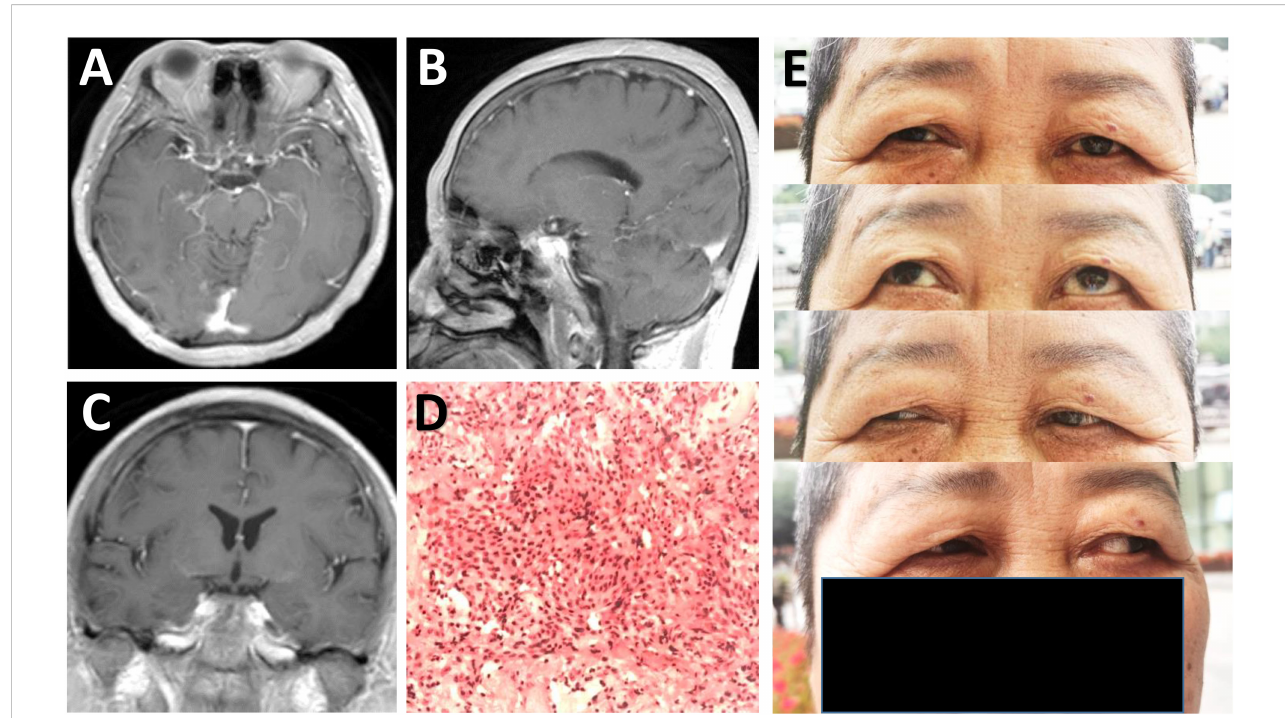
FIGURE 3 Radiological and pathological evaluation of the lesion postoperatively. (A-C) Postoperative post-contrast axial (A) , sagittal (B) , and coronal (C) MRI scans performed one month after surgery showing total removal of the lesion. (D) Photomicrograph of hematoxylin-eosin staining showing typical features of meningothelial meningioma. (E) Physical examinations at one month follow-up indicating no limitation in eye movements.